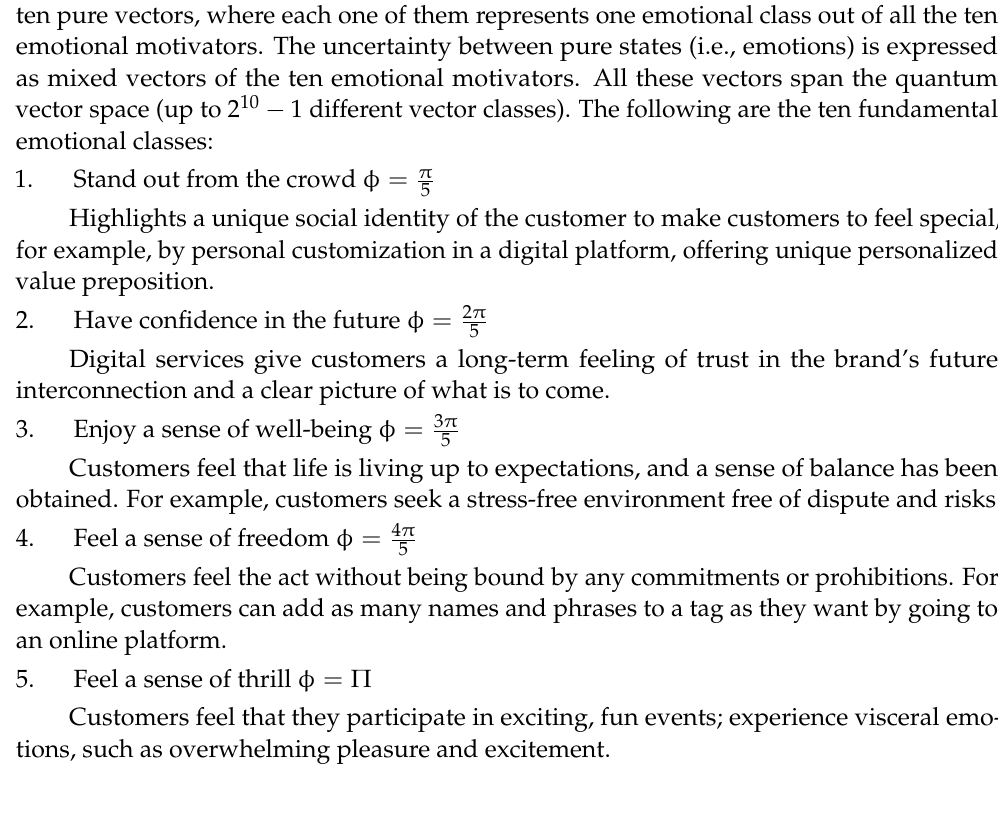
, Π e their projectors. ( a ) The outcome when first 2 1 · Π e | ψ (cid:105)(cid:107) 2 . ( b ) The outcome when first asking Q 2 2 1 · Π e ) < P ( Q ) | ψ (cid:105)(cid:107) 2 . In that case, P ( Q 2 then Q 1 1 then Q 2 2 1